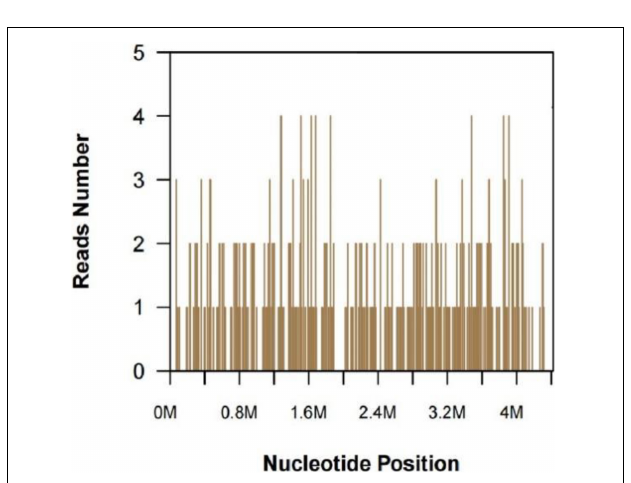
FIGURE 3 | Next-generation sequencing and metagenomics analysis. Proteus mirabilis specific reads and its nucleotide position along the Proteus mirabilis